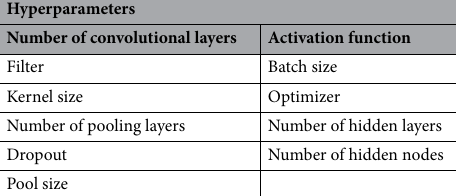
Table 2. List of hyperparameter